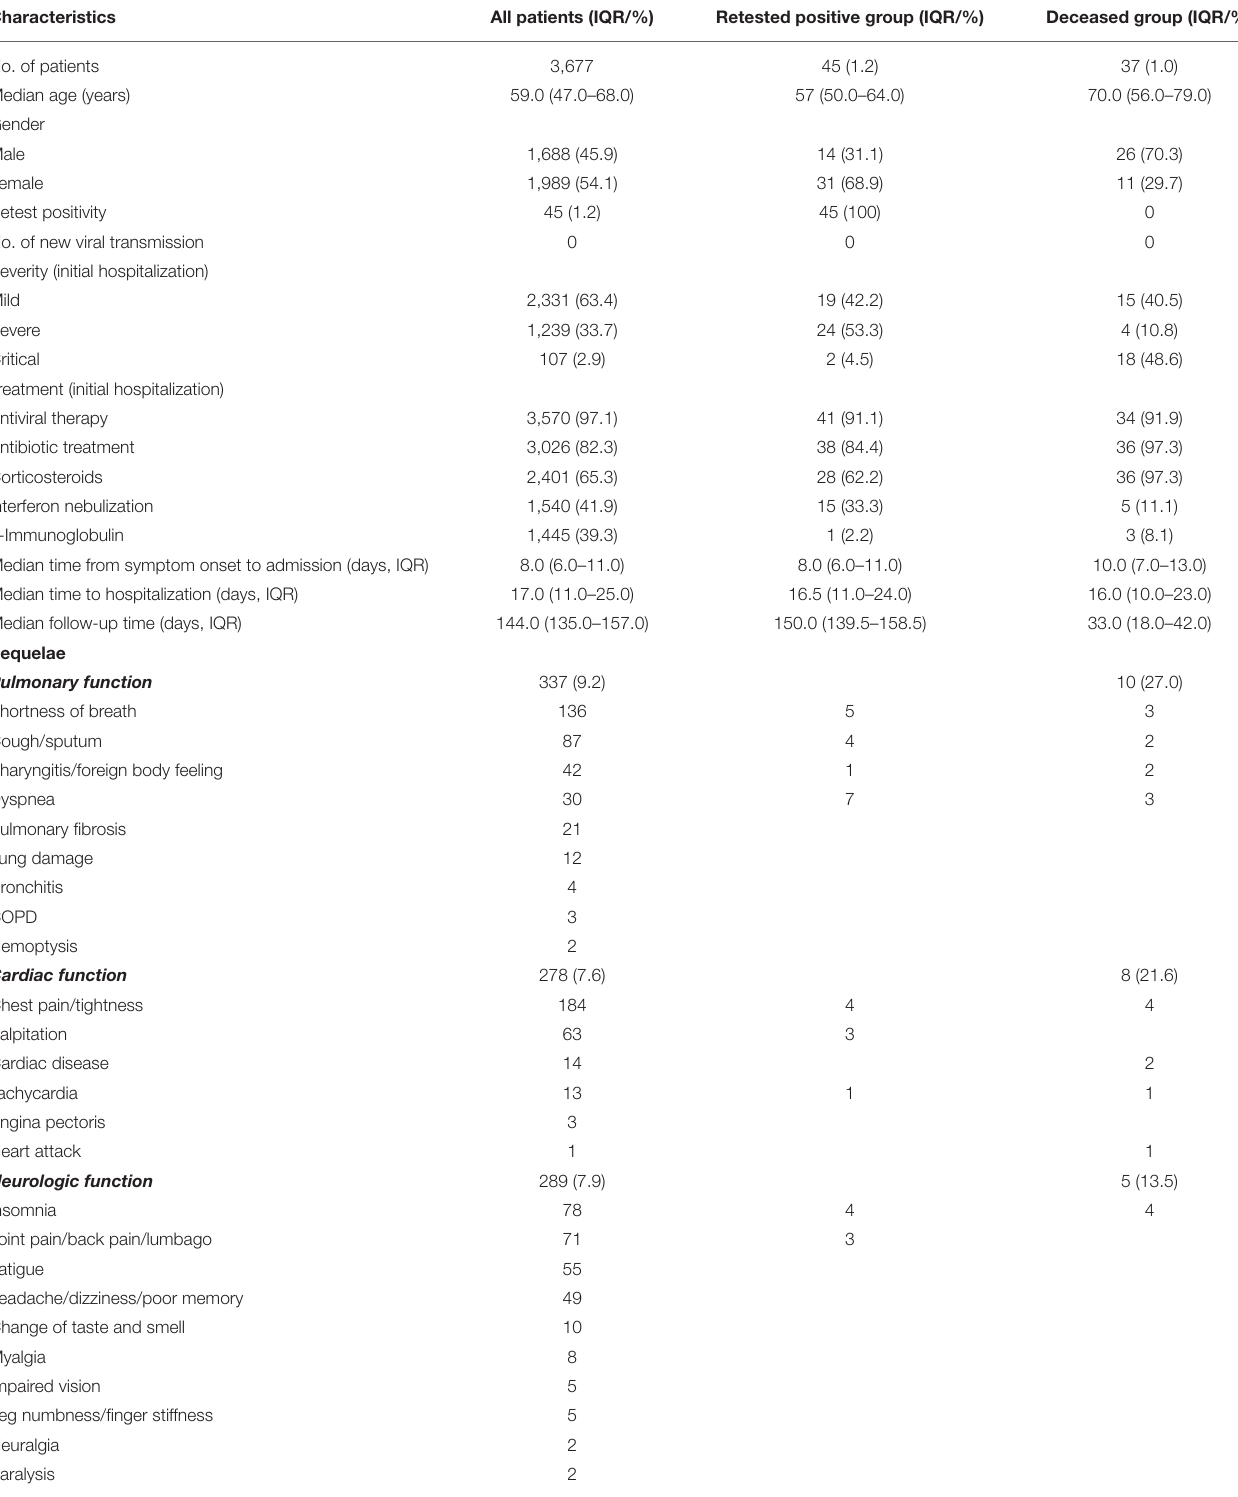
TABLE 3 | Clinical characteristics, retest positivity, and sequelae among discharged coronavirus infectious disease-2019 (COVID-19) patients.